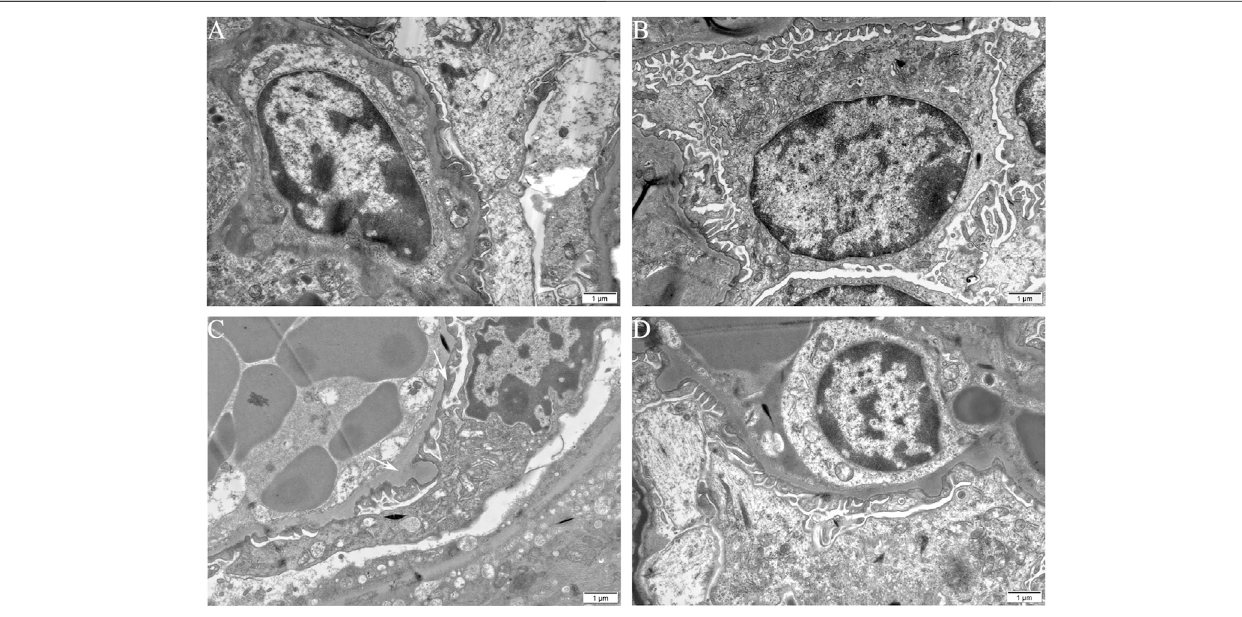
FIGURE 2 | Podocyte morphological changes involved in TCE-induced glomerular damage. Representative observations in transmission electron microscopy ( n (cid:1) 5pergroup,magni fi cation, × 15000)ofmiceglomerulusfromblankcontrolgroup (A) ,vehiclecontrolgroup (B) ,TCEposgroup (C) ,TCEneggroup (D) .Whitearrows show podocyte hypertrophy with thickened glomerular basement membrane, fusion of foot processes in TCEpos group. Scale bars: 1 µm.